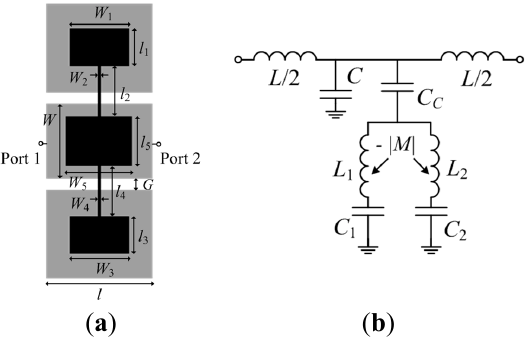
Figure 5. ( a ) Coplanar waveguide (CPW) loaded with a 5S-SIR and (b) circuit model. Relevant dimensions are indicated.